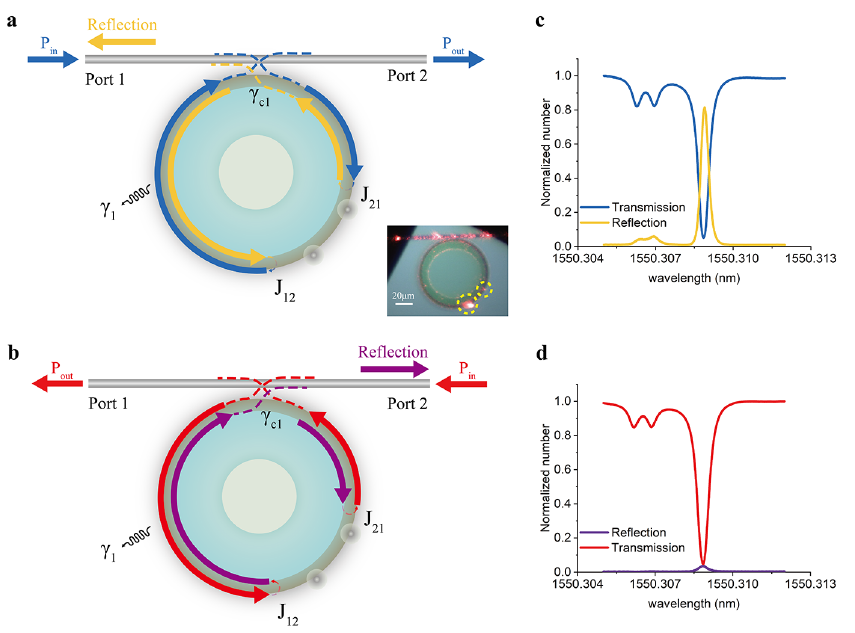
Fig. 3 Unidirectional reflector in a one-port perfect absorber. ( a ) and ( b ) Schematic diagrams of unidirectional reflectors in a one-port perfect absorber with an incident beam from left and right ports, respectively. γ 1 : scat- tering loss, γ c 1 : coupling rate. The linear coupling rates between CW and CCW are not equal in the current case, = J 21 in the current microcavity. Inset in ( a ): top-view picture of the microcavity device. ( c ) and ( d ) Their i.e. J 12 (cid:27) corresponding transmission and reflection spectra from left and right, respectively, show the same transmission from both ports, but two distinguished reflection